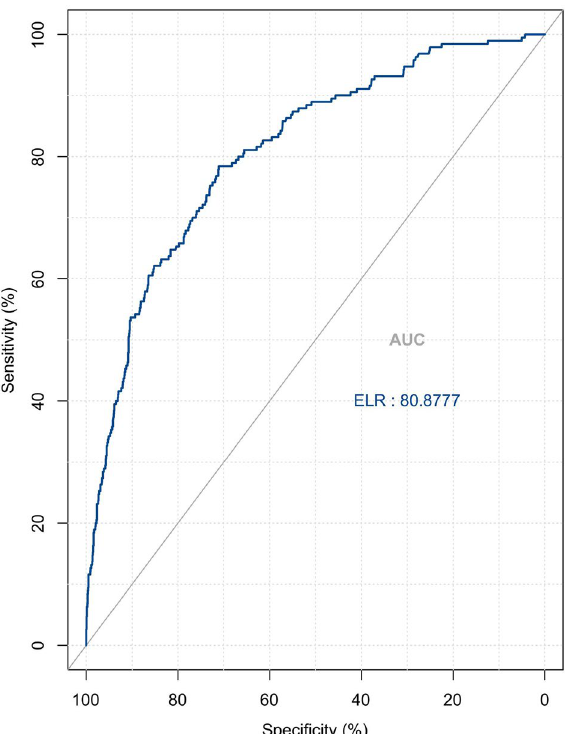
Figure 4. ROC curve for KD diagnosed by ELR. AUC = 0.809.